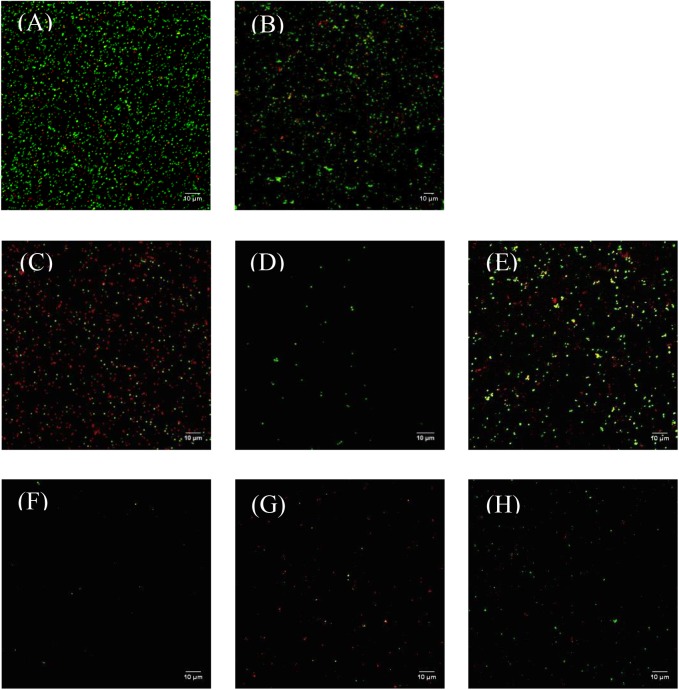
Representative CLSM images of Staphylococcus aureus labeled with PI and DCFDA fluorochromes after 5 or 120 min of O2, Ar, or N2 NTP treatments. DCFDA+ and PI– bacteria (green). DCFDA+ and PI+ bacteria (yellow). DCFDA– and PI+ bacteria (red). (A) Control; (B) 5 min low pressure; (C) 5 min O2; (D) 5 min Ar; (E) 5 min N2; (F) 120 min O2; (G) 120 min Ar; (H) 120 min N2.